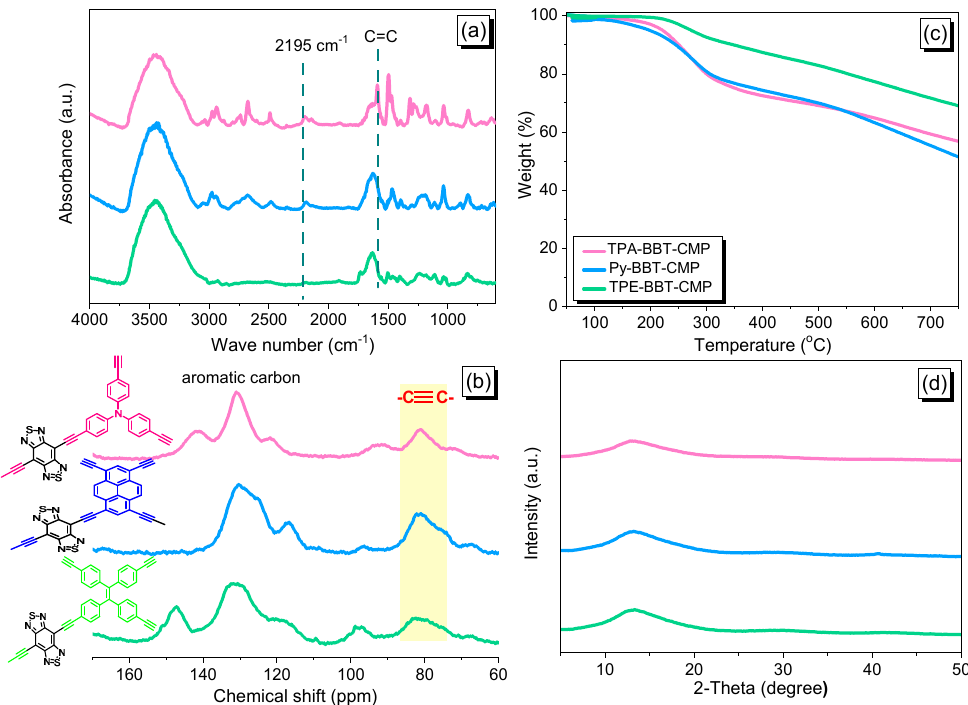
Figure 1. ( a ) FTIR, ( b ) TGA, ( c ) solid-state NMR, and ( d ) XRD spectra of the TPA–BBT–CMP, Py–BBT–CMP, and TPE–BBT–CMP.